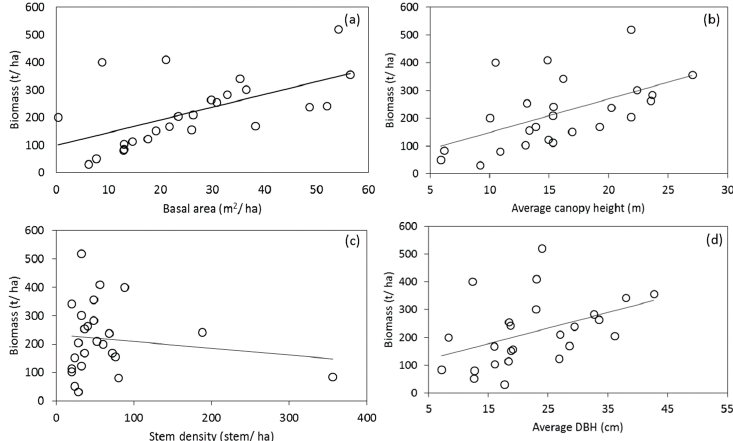
Figure 3. Calculated aboveground biomass values for the field plots against ( a ) basal area; ( b ) average canopy height; ( c ) stem density and ( d ) average diameter at height.